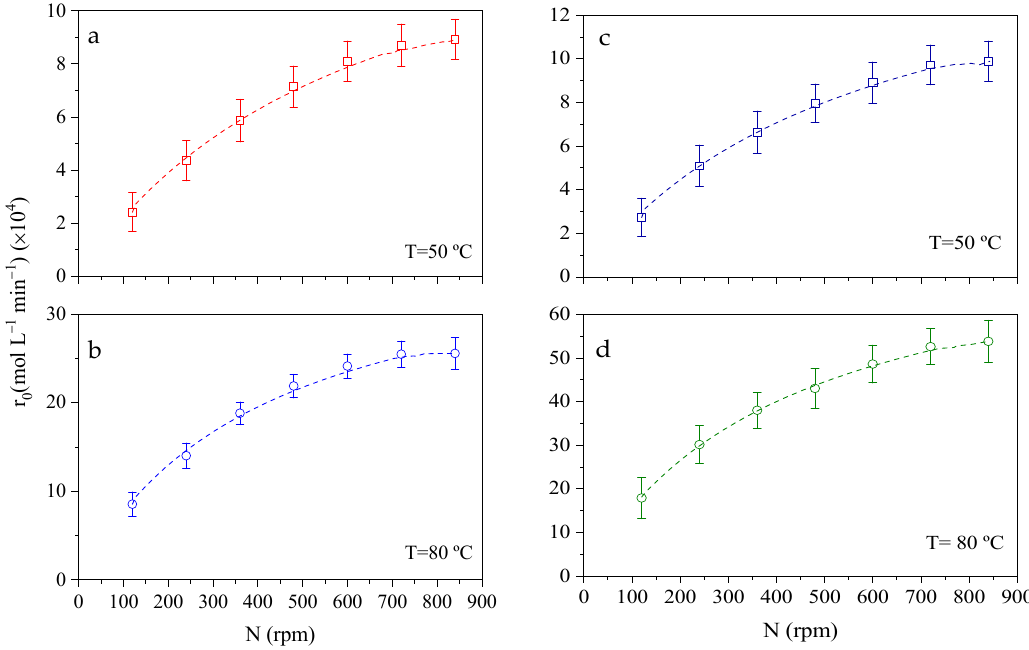
Figure 6. Influence of the stirring speed (mixing) on the initial rate of esterification in a triphasic glycerol-toluene-N435 (L-L-S) system with no added water at zero time: ( a ) 50, ( b ) 80 °C, and with 7.4% v / v of water added initially ( c , d ). In both systems for 50 ( ) and 80 °C ( ) and fixed operational conditions: C I0 = 100 g·L − 1 , C E = 30 g·L − 1 .